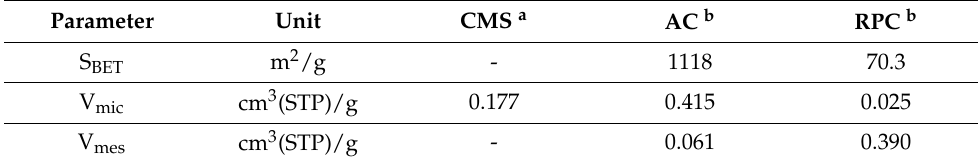
Table 1. Characterization of the investigated